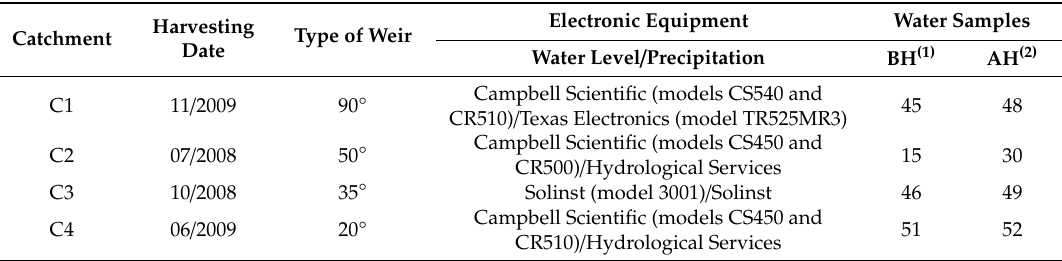
Table 2. Harvesting dates, type of weirs, water level and rain gauge equipment, and number of water samples collected at